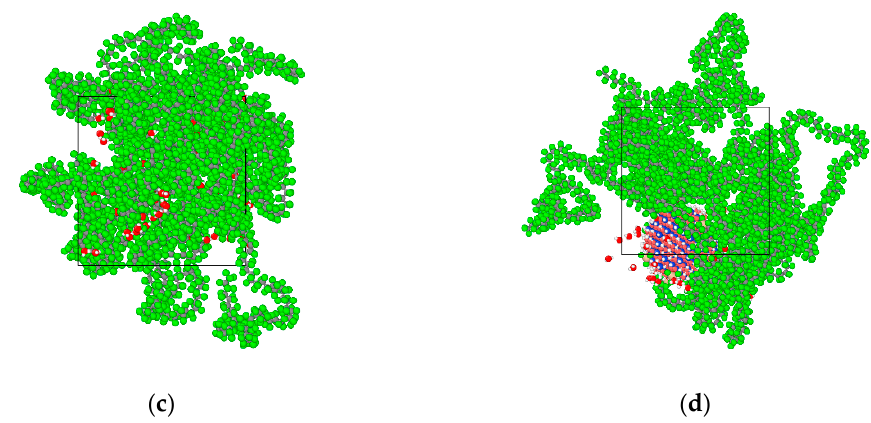
Figure 1. Polytetrafluoroethylene (PTFE) model and its composite models: ( a ) PTFE model; ( b ) boron nitride (BN)/PTFE model; ( c ) water/PTFE model; and ( d ) water/BN/PTFE model.